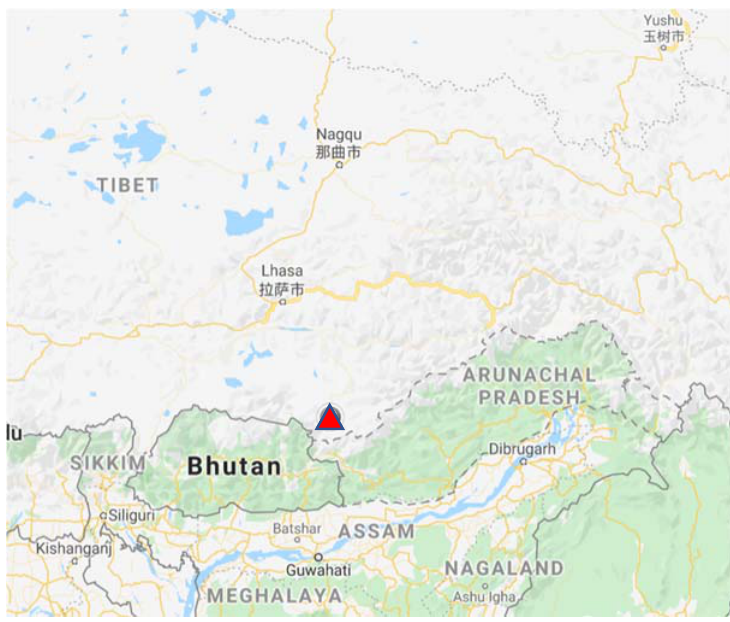
Figure 1. Location of Cuona county of Tibet. The red triangle is where Cuona located.